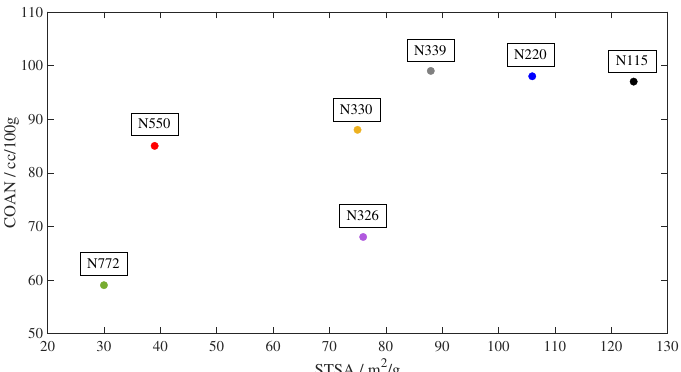
Figure 6. Colloidal plot showing the tested carbon black types. The abscissa represents the exter- nal surface area (STSA) and the ordinate represents the oil absorption number of the compressed sample (COAN).